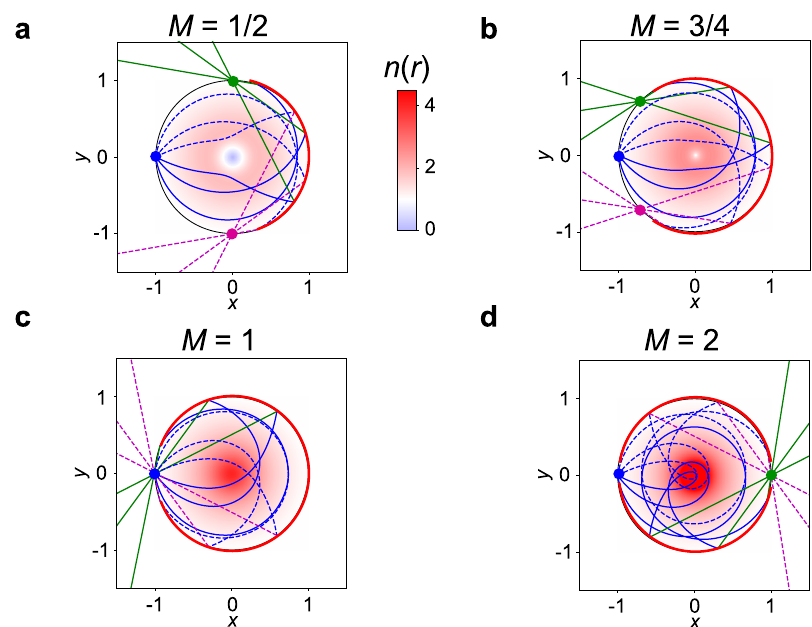
ffiffiffiffiffiffiffiffiffiffiffiffiffi p (cid:7) (cid:8) 1 þ 8 r